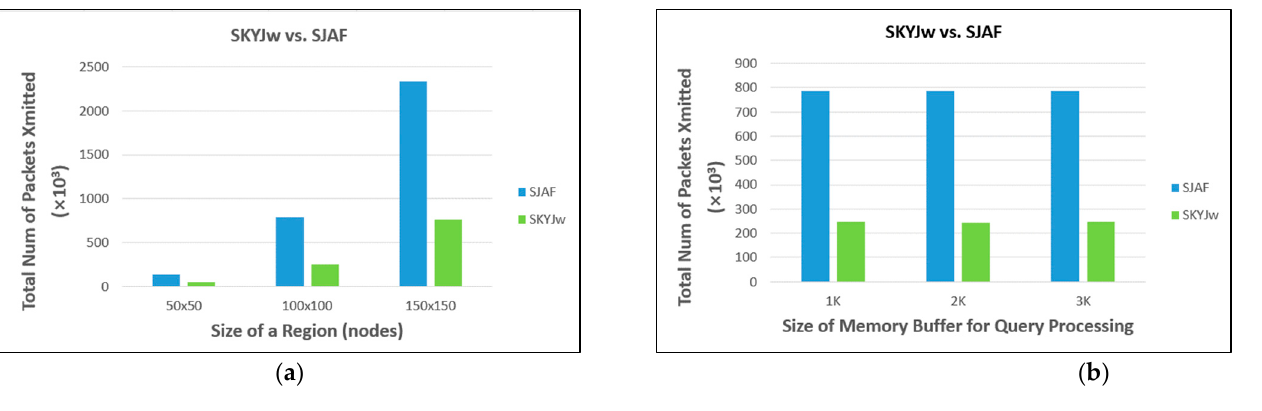
Figure 13. Comparison between SKYJw and SJAF ( a ) as the size of a region varies ( b ) when the size of memory buffer for query processing is constrained .